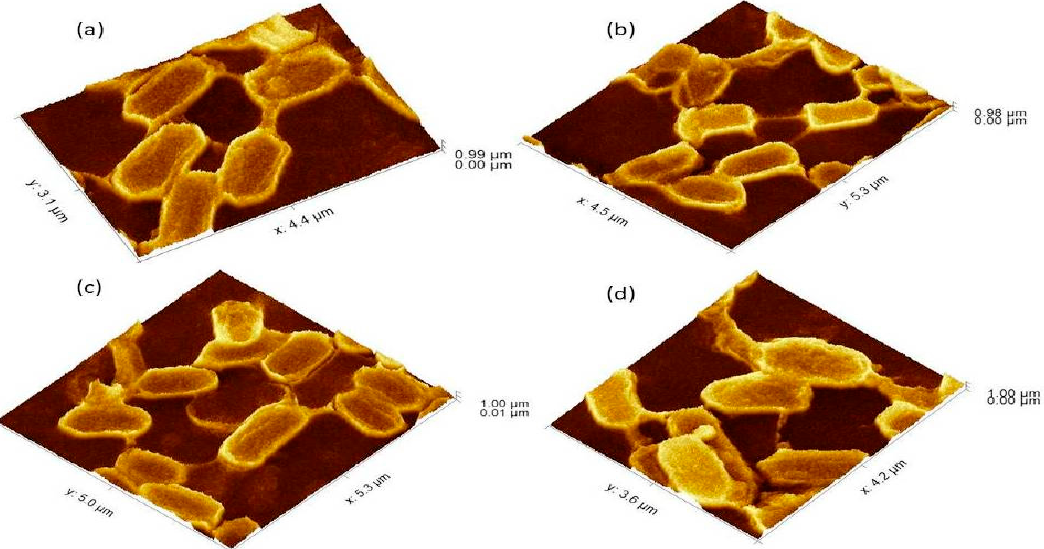
Figure 3. The 3Drepresentation of biofilm-positive cells occupying the lower base of biofilm consortia and adhered to the glass surface. The weight was not applied to these cells, therefore, the cells maintained typical P. aeruginosa morphology i.e. rod shape. ( a ): Cells with normal P. aeruginosa morphology. ( b ): In this 3D image, the formation of nanotubes can be visualized connecting surface-attached cells of adherent biofilms. ( c ): cells connected Side by side as well as through nanotube. ( d ): Extracellular matrix material attached to the cell surface.